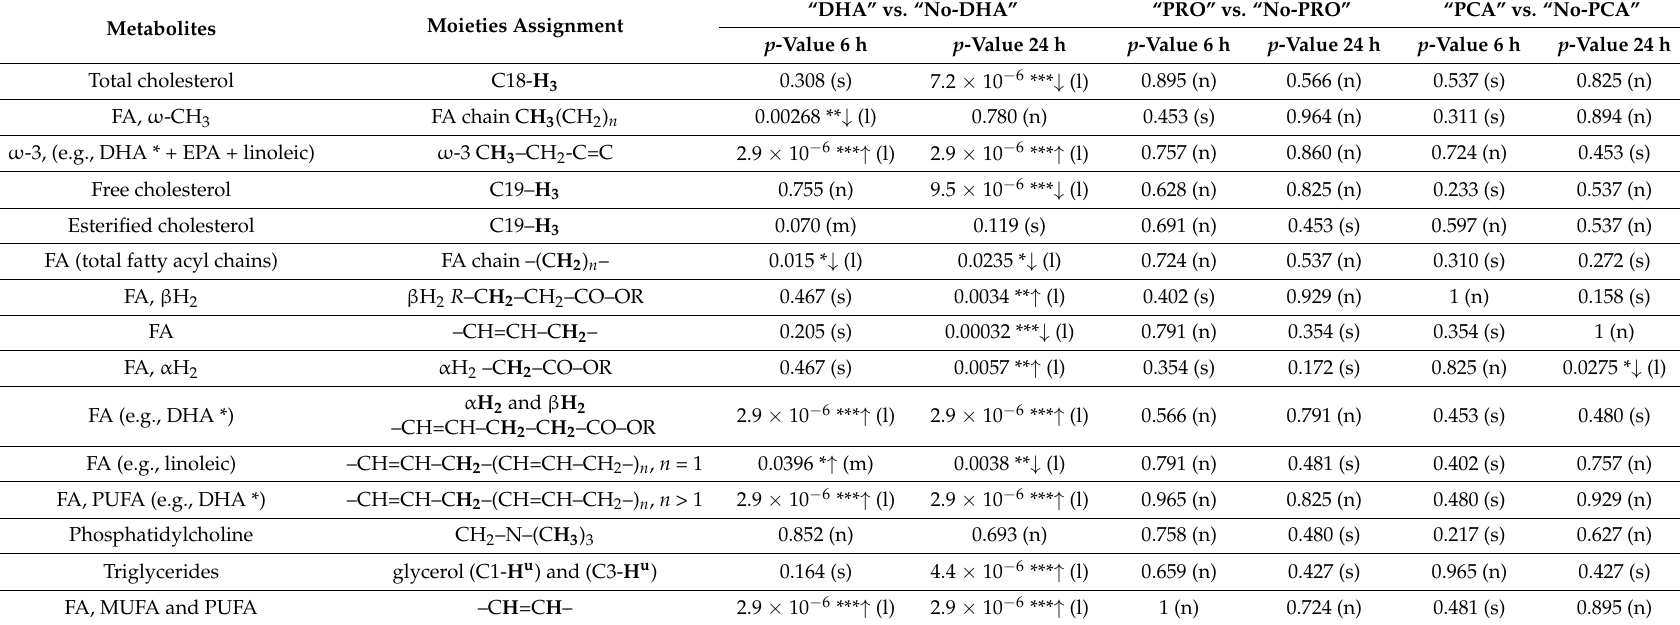
Table 1. List of lipid groups whose signals were assigned and integrated in the nuclear magnetic resonance (NMR) spectra. For each comparison, the corresponding p -value of the Wilcoxon test and the Cliff’s delta (Cd) effect size are reported (* p < 0.05; ** p < 0.01; *** p < 0.001, n = negligible, s = small, m = medium, l = large). The signals whose intensities were significantly higher or lower in “DHA”, “PCA” and “PRO” groups are marked with ↑ or ↓ ,